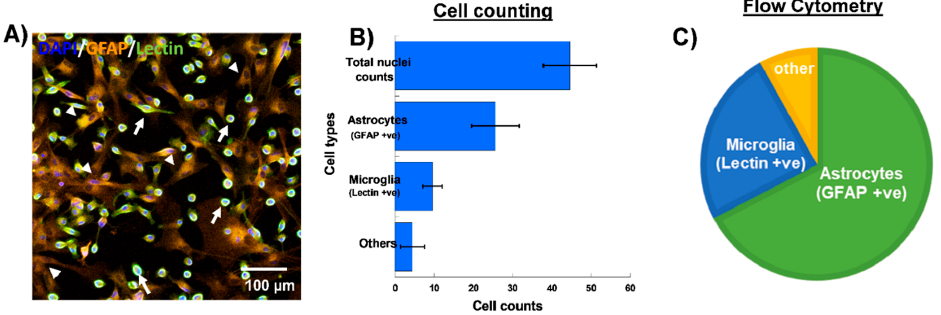
Figure 1. Characterization of mixed glial cell culture from neonatal rabbit brains. ( A ) Confocal microscopy image of mixed glial culture showing microglia/macrophages ( Green stained with lectin, white arrows), astrocytes ( Orange , stained with GFAP, white arrow heads) and the cell nuclei stained with DAPI ( Blue ). ( B ) Evaluation of different cell population using cell counting from confocal microscopy images. ( C ) Evaluation of percentages of different cell populations present in the mixed primary glial culture using flow cytometry. Scale bar 100 μ m.